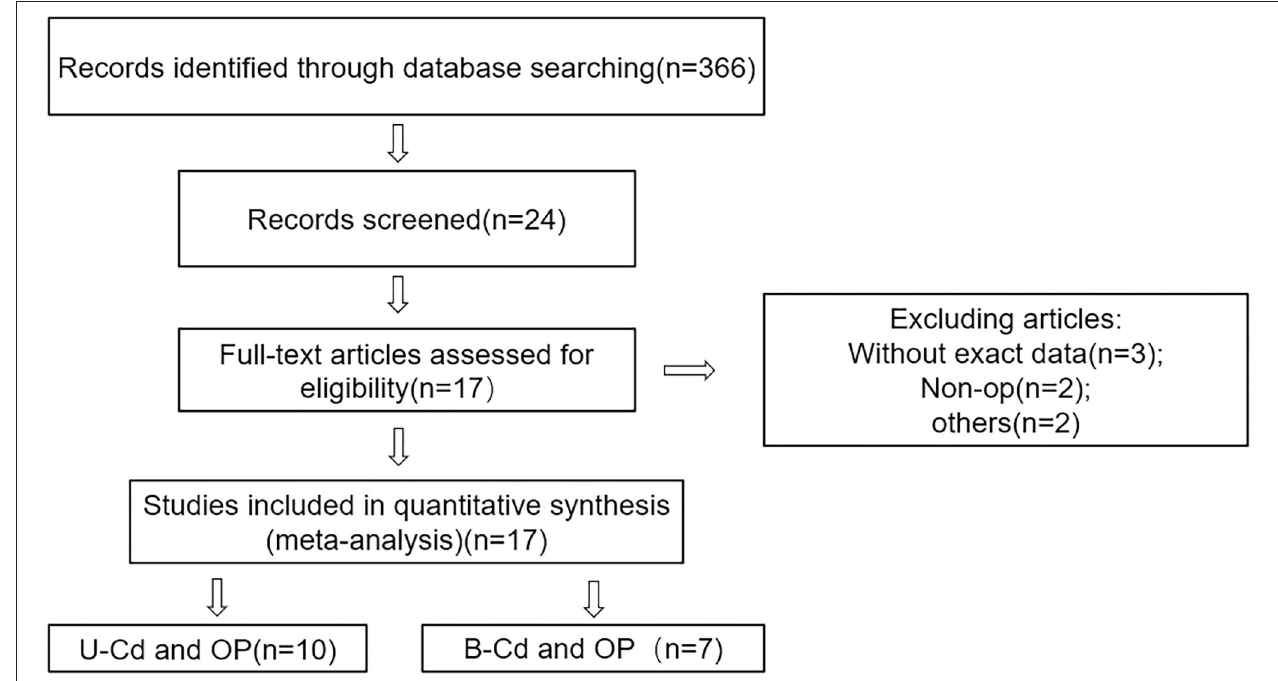
FIGURE 1 | Flowchart of the studies